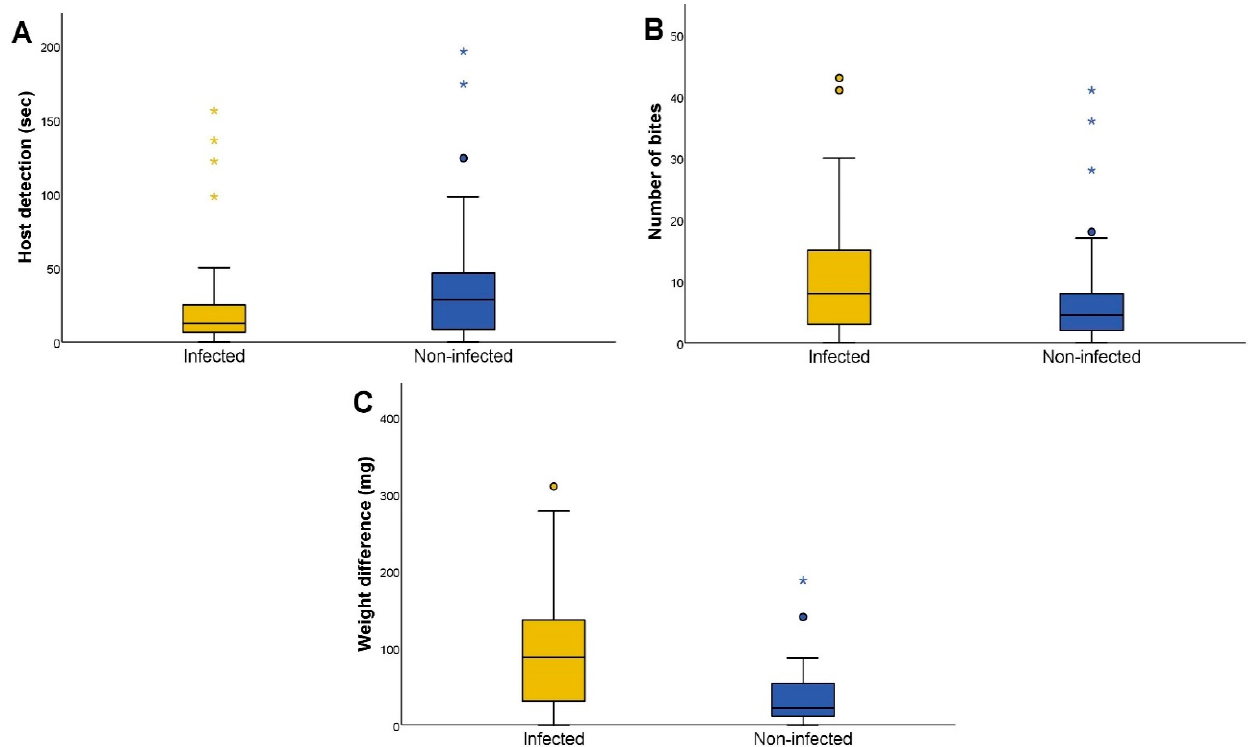
Figure 2. Feeding activity according to the Trypanosoma cruzi infection status of Triatoma infestans . ( A ) Host detection time, in seconds, of T. cruzi -infected and non-infected T. infestans . Host detection is defined as the time elapsed since the triatomine begins to mobilize in the arena until the moment when the insect starts walking towards the host. ( B ) The number of bites performed by T. cruzi -infected and non-infected T. infestans . The number of bites is defined as the total number of bites performed. ( C ) The weight difference, in milligrams, of T. cruzi -infected and non-infected T. infestans . The weight difference is defined as the subtraction of the initial experimental weight from the final weight. The circles represent outliers and the asterisks represent extreme outliers, calculated as previously reported [24].